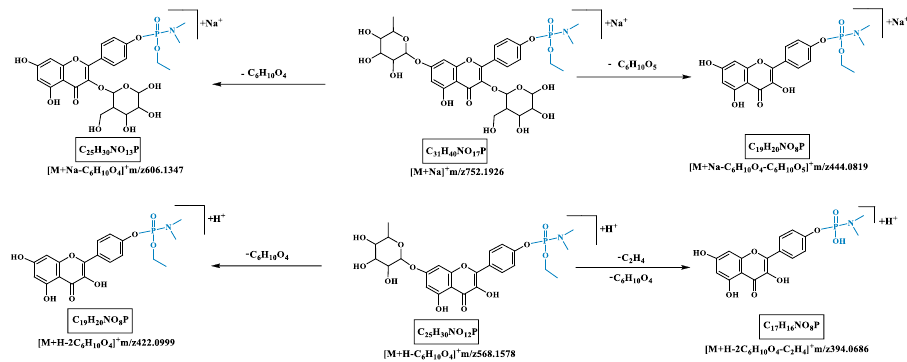
Figure 10. Possible fragmentation pathways of product ions for compound 5.